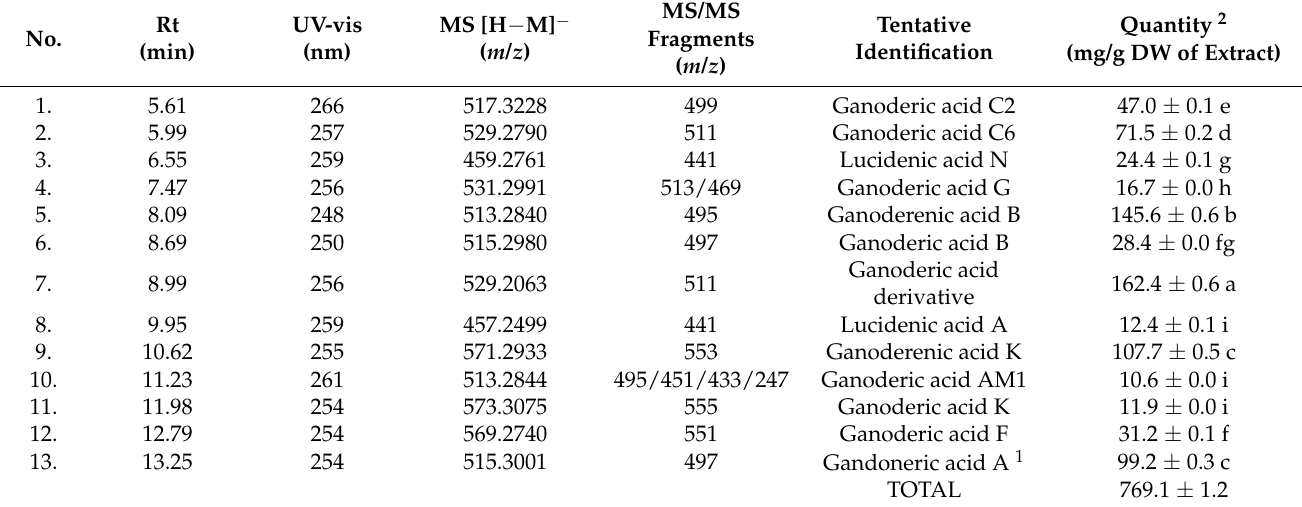
Table 2. Profile and quantity (mg/g DW) of triterpenoids in extract of Ganoderma lucidum .